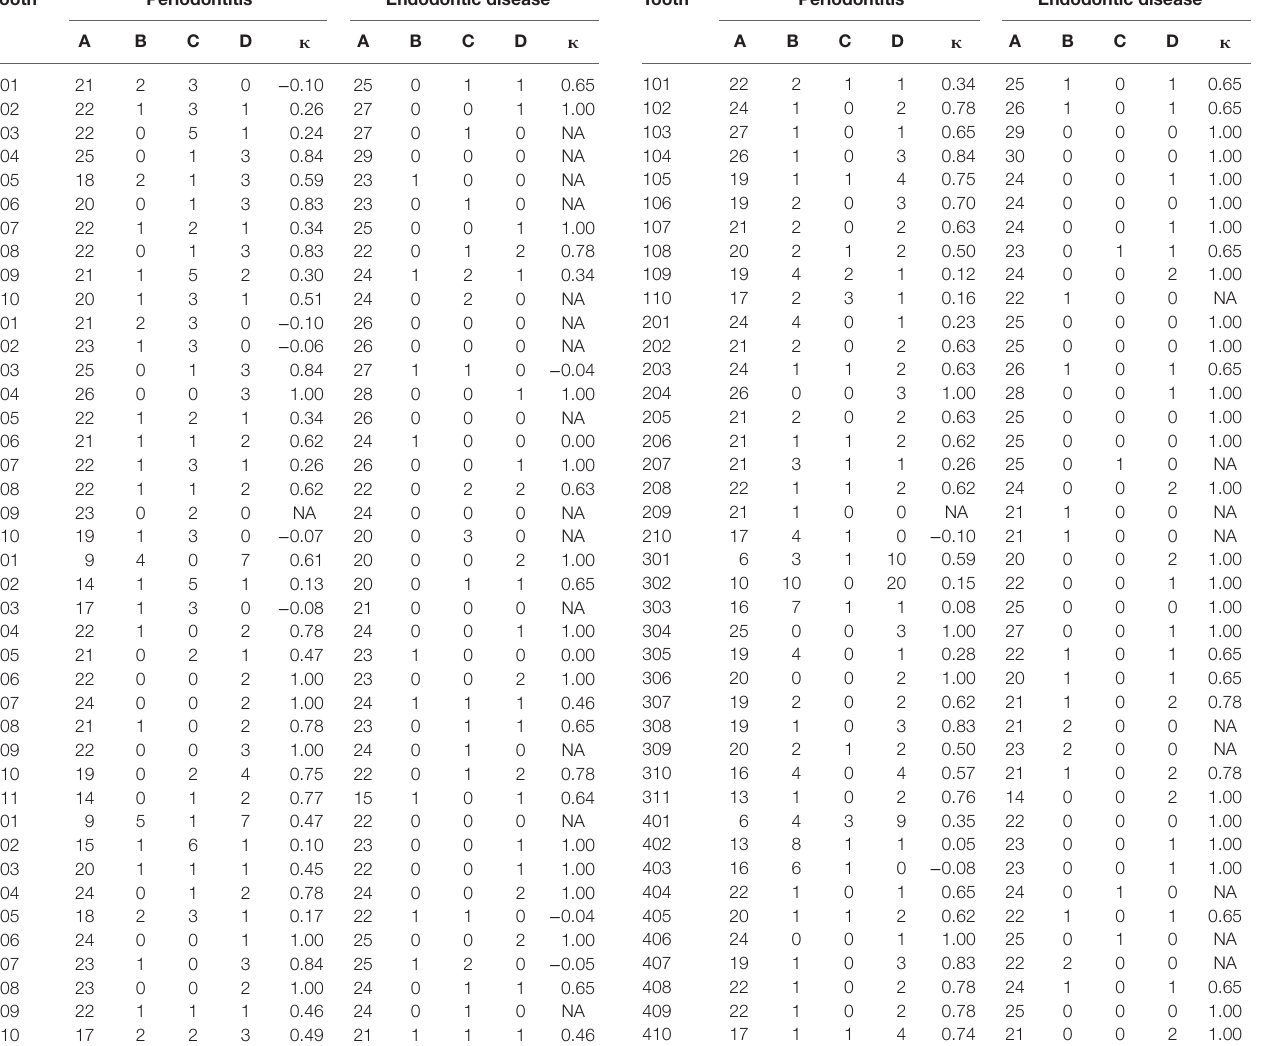
TaBle 2 | Method comparison by Observer 2. Tooth